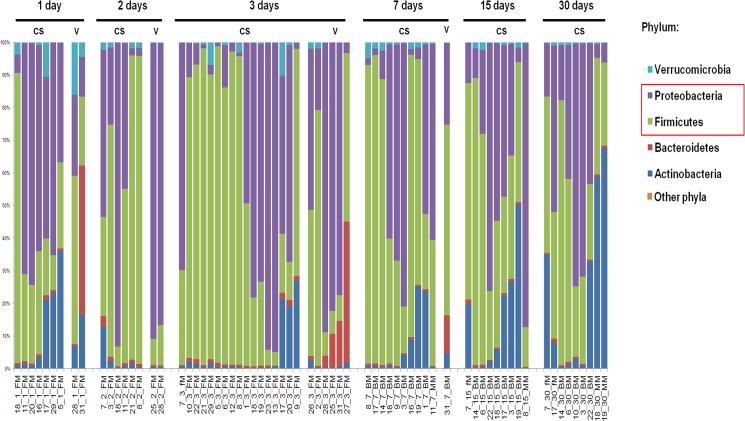
Composition at phylum level of the gut microbiota profiles of 31 infants enrolled in the study for 30 days following birth.At each time point, the gut microbiota was characterized by HITChip-based phylogeny.